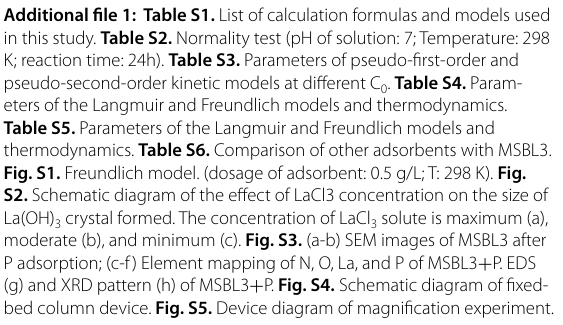
P. Fig. S4. Schematic diagram of fixed- + bed column device. Fig. S5. Device diagram of magnification